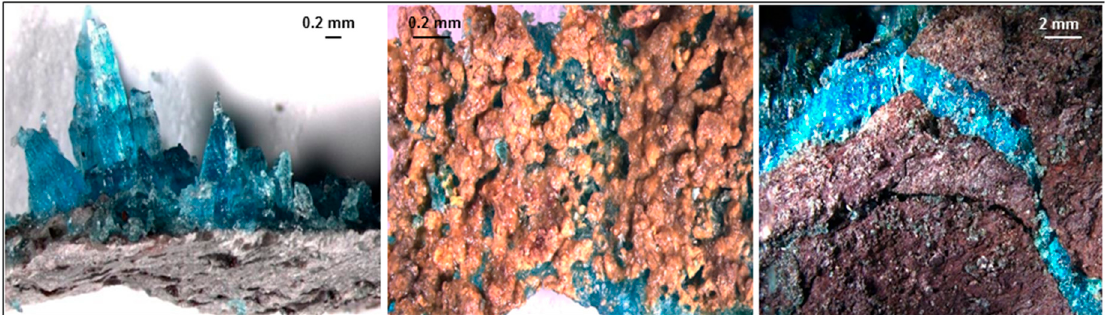
Figure 3. Stereomicroscope images of chalcanthite (blue) over chlorite / clinochlore (volcanic rock, grey), jarosite (brownish) and hematite (reddish), as they occur in the adit wall.